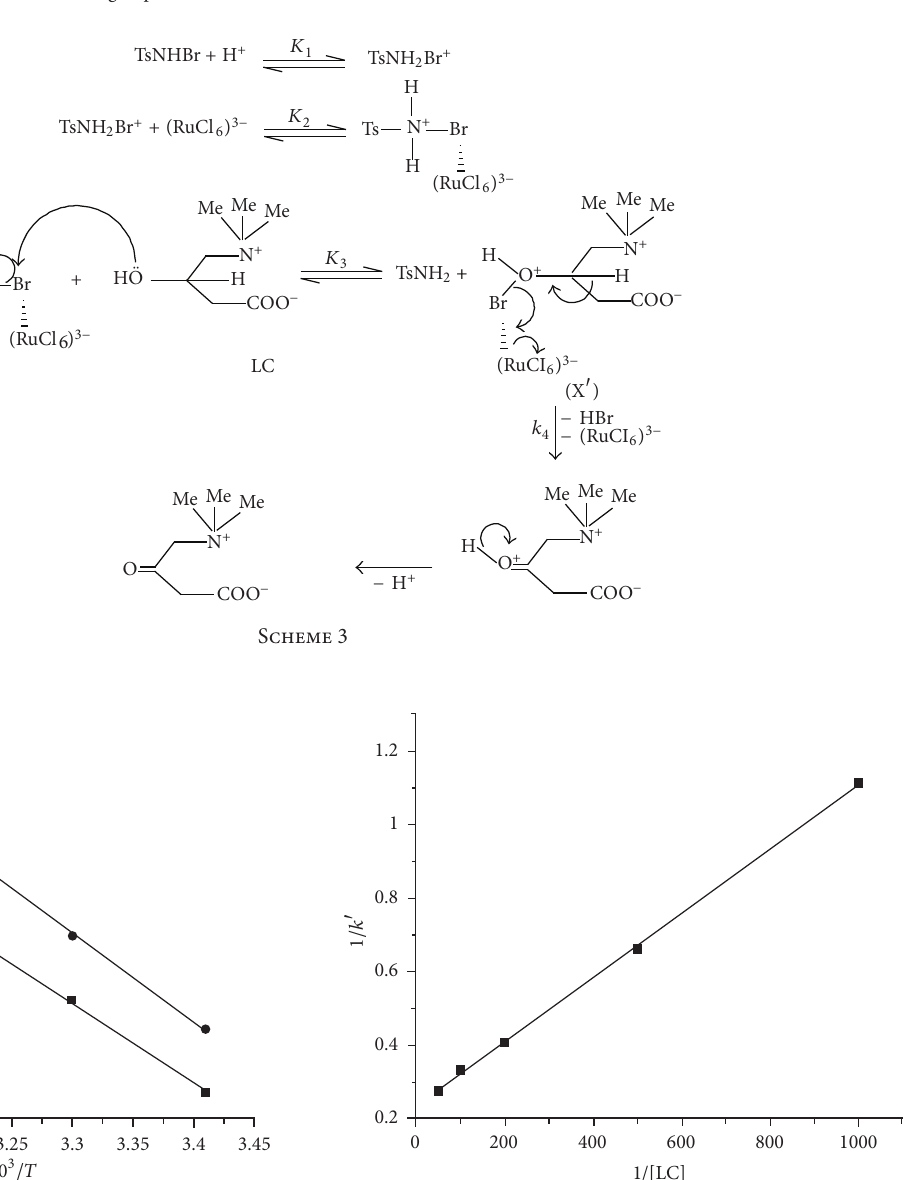
In Scheme 2, X and X are the intermediate complex ′